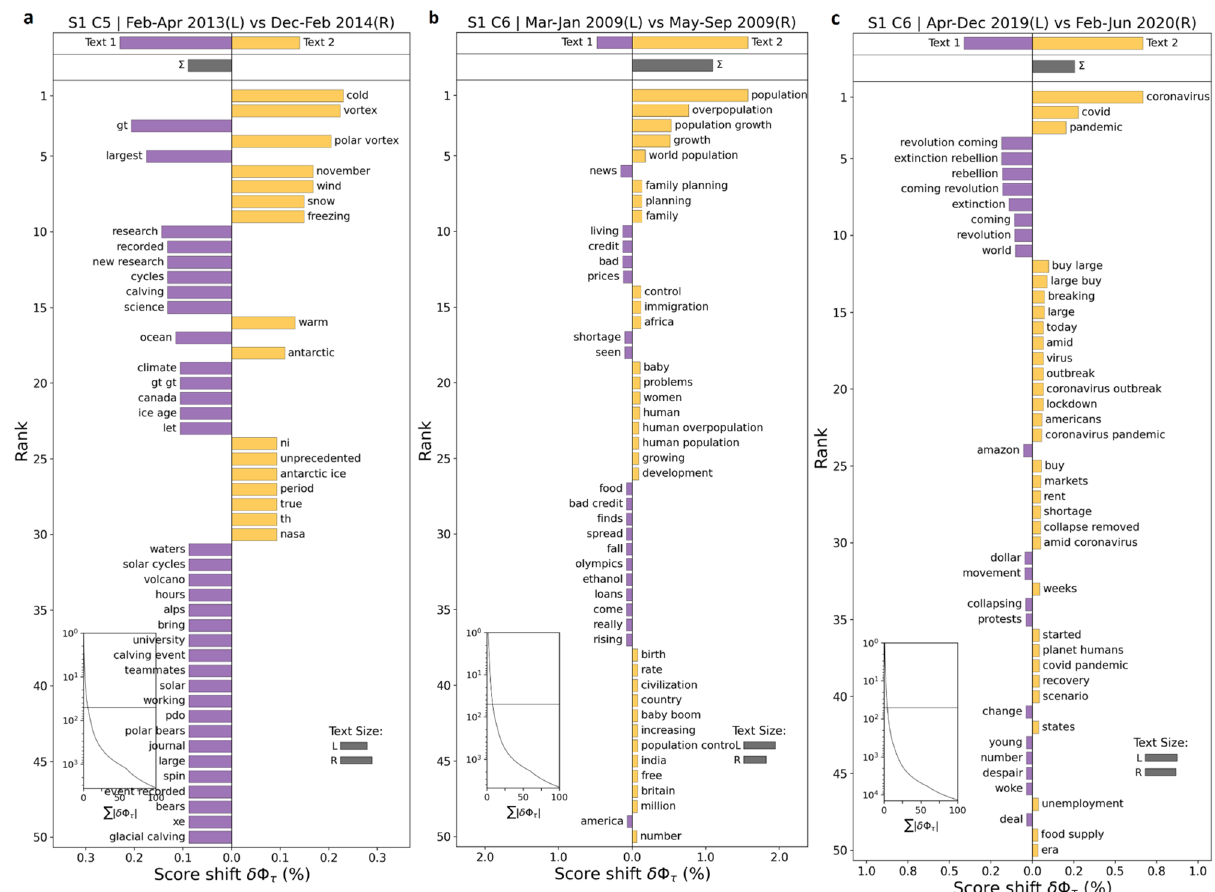
Figure 13. Word shift graphs for Global warming ( a ) and Population & economy ( b , c ) clusters showing the texts from the time periods with unusually high vs. low user activity. The discussions within the Global warming cluster spiked in 2014 mainly as the early North American cold wave , also known as “polar vortex” , hit parts of Canada and parts of the US ( a ). In the Population & economy cluster, we see a sharp rise in discussions beginning in early 2009 reaching an all-time high peak in the month of July with the publication of the State of World Population 2009 report by the UN ( b ). Another peak within the cluster was observed in 2020 as the focus of the discussions shifted towards Covid-19 ( c